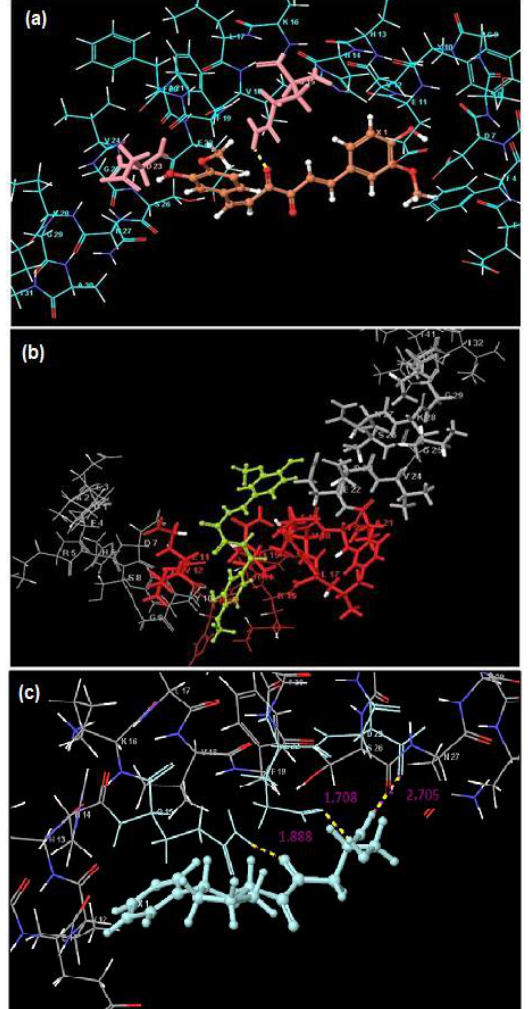
Figure 7. Binding of Curcumin (C) and Glyconornicotine (G) to respective sequences of the Aβ peptide with H-bond formation of the optimal poses docked into 1Z0Q also 1-42 shown. ( a ) C: possibility of 2 H-bonds between the proteins (residues highlighted in pink); ( b ) C: highly stable pose apart from optimal conformation and ( c ) G: optimal pose with values (magenta indicates H-bonding